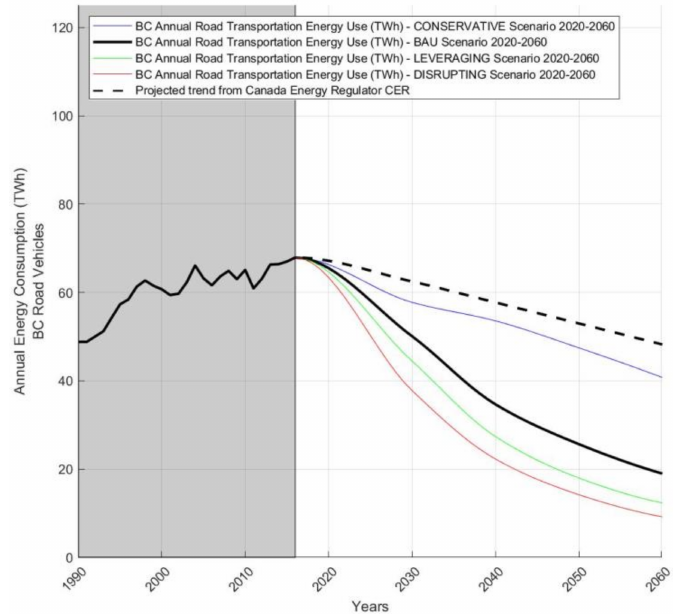
Figure 13. B.C. road transportation annual energy use in (TWh), all effects presented in Tables